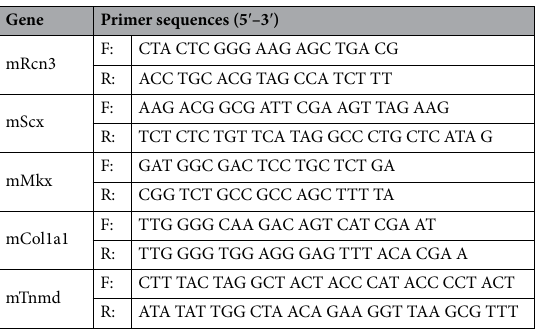
Table 2. Primer sequences for the quantitative real-time